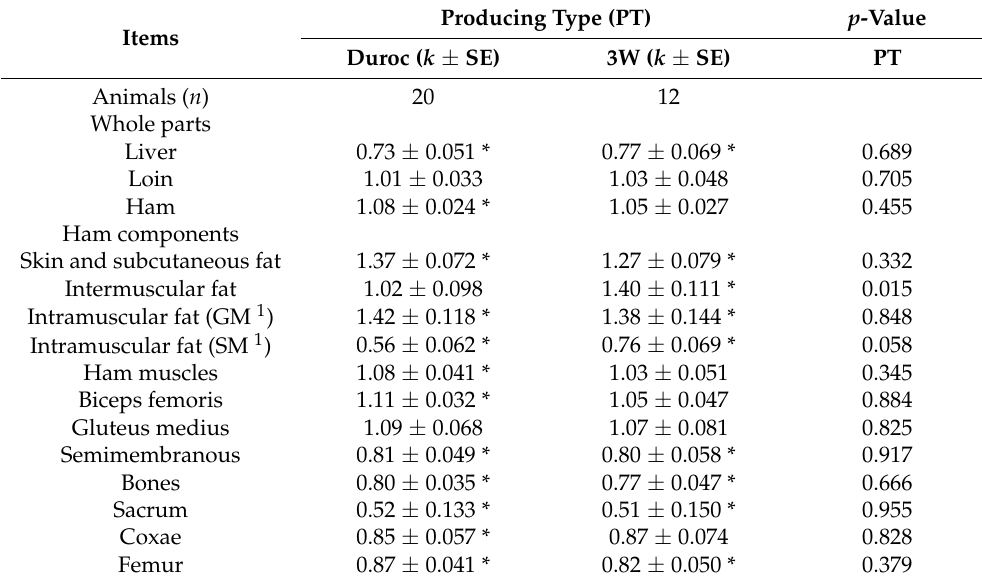
Table 3. Allometric coefficients ( k ) of liver, loin, ham, and ham components, in two producing types (PTs) of pigs (three-way (3W) crossbred pigs and purebred Duroc pigs) between 80 and 150 days of age with 28 and 87 kg body weight,